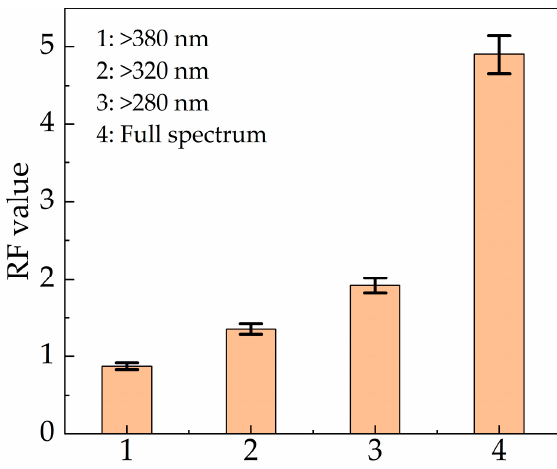
Figure 9. Sub-band RF values of pulsed xenon lamp. Table 3. RF values of various mono-color light wavelengths.